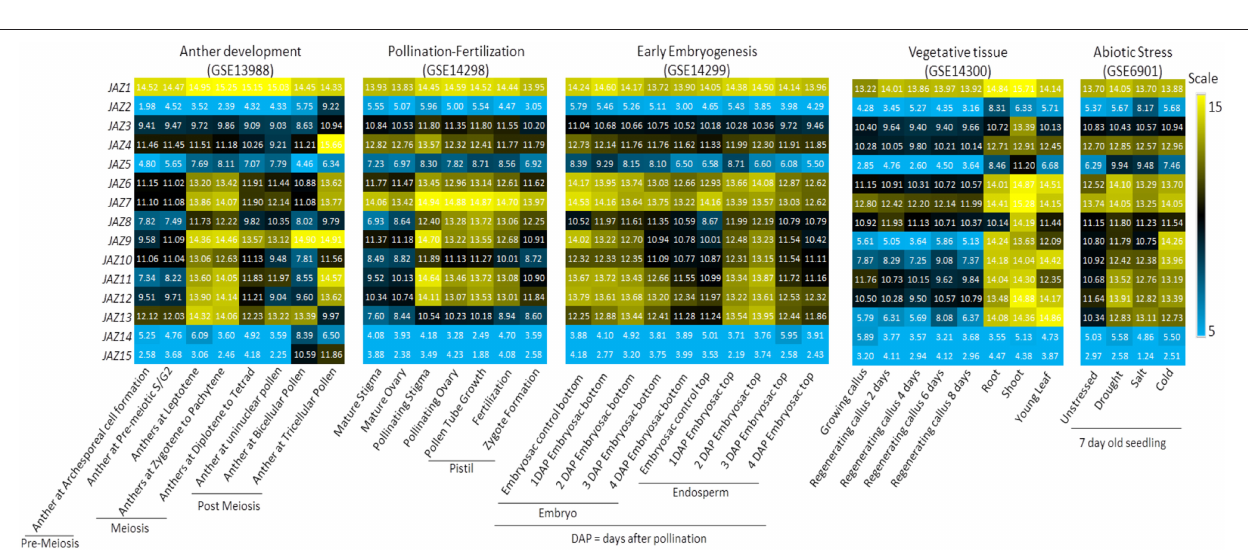
FIGURE 4 | Gene expression profile for CaJAZ genes in germinating seedling (GS), young leaf (YL), and 8 week stages of flower development [flower bud (4mm; FB1), flower bud (6mm; FB2), flower bud (8mm; FB3), flower bud (8–10mm; FB4), flower (unopened; FL1), flower (opened; FL2), flower (mature; FL3), and flower (drooped; FL4)]. Expression data was retrieved from CTDB (http://www.nipgr.res.in/ctdb.html). Scale bar is showing relative transcript levels. Numbers on boxes show RAM (reads per million) values.